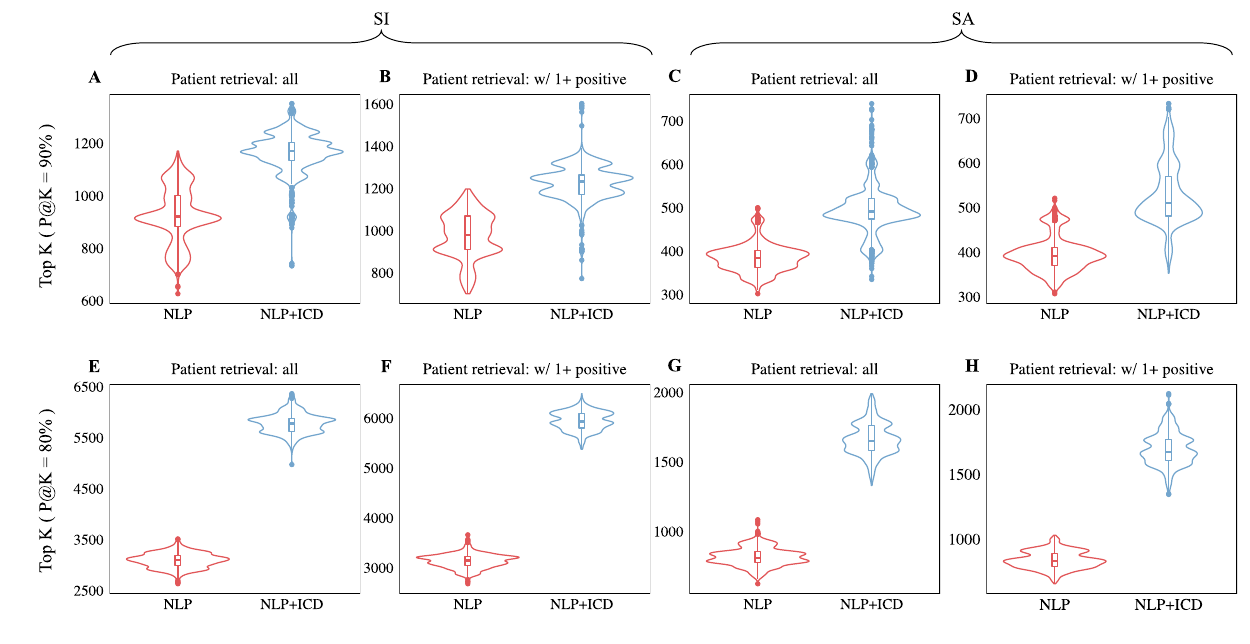
Figure 5. Comparative analysis for extracting the top K highest ranked suicidal ideation (SI) and suicide attempt (SA) patients using various configurations of the suicide label assignment method described in Fig. 1 . For each configuration, the label assignment method was run 1000 times. The “Patient retrieval: all” experiments include all the patients retrieved by the NLP system while the “Patient retrieval: w/ 1+ positive” experiments use only patients with at least one positive suicide mention in their notes. The “NLP” and “NLP + ICD” experiments were associated with methods using the label assignment probabilities p rank and p NLP + ICD , respectively.